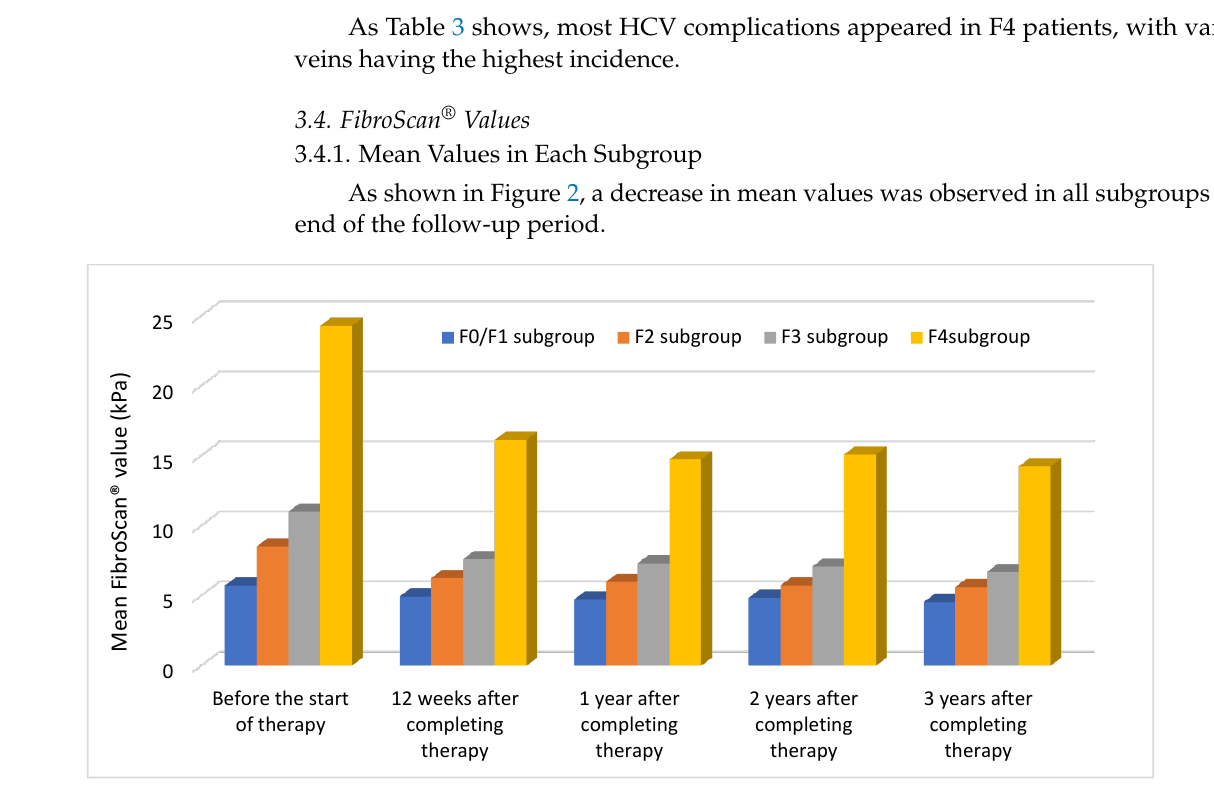
Figure 2. Trend of mean FibroScan ® values in each subgroup according to the baseline fibrotic stage throughout the follow-up period.